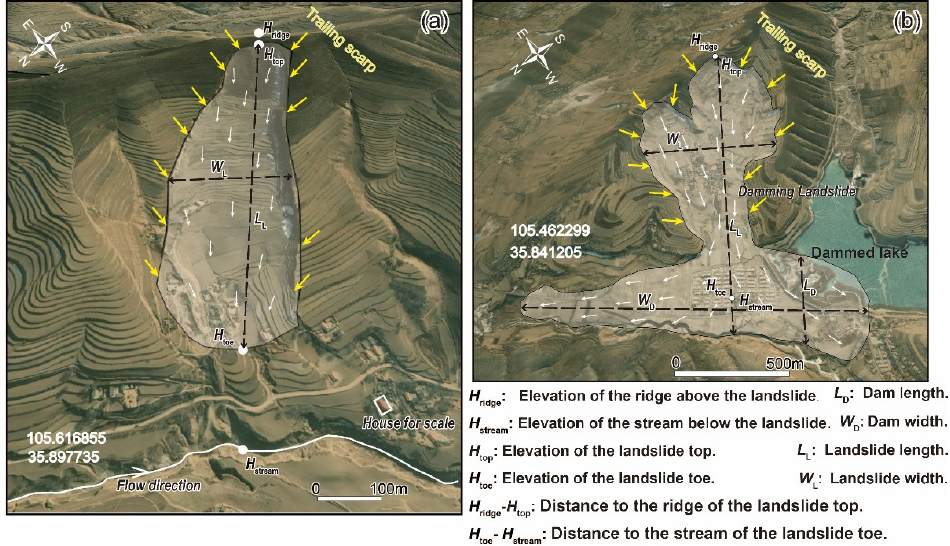
Figure 5. Interpretation principle and the attribute statistics method for ( a ) non-damming and ( b ) damming landslides. Yellow arrows depict the locations of the trailing edge and side edge, and white circles depict the locations of altitude values. The arrows indicate the measurement principles of the parameters. Note that we measured the length from the landslide’s top to the toe as the landslide length and the maximum width of the transition area as the landslide width.